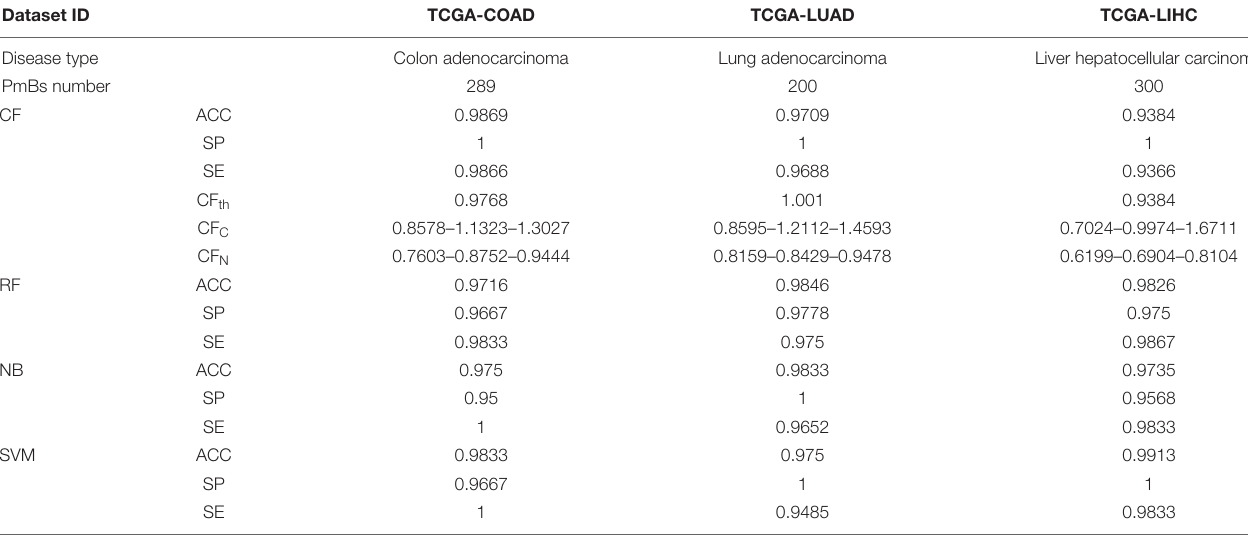
TABLE 5 | Generalization ability verification